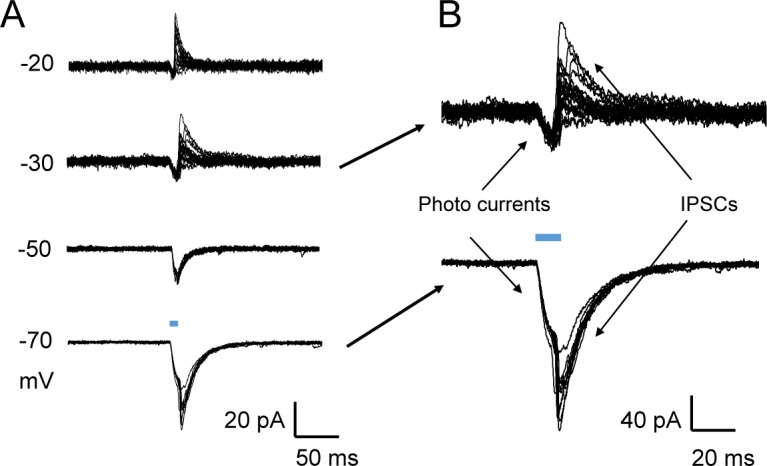
Optostimulation evoked lateral inhibition among GABAergic neurons.(A) Voltage clamp recording for light evoked inward currents. The holding potential were stepped from -20 to -70 mV. (B) Enlarged traces from holding potentials at -30 (upper) and -70 mV (lower).